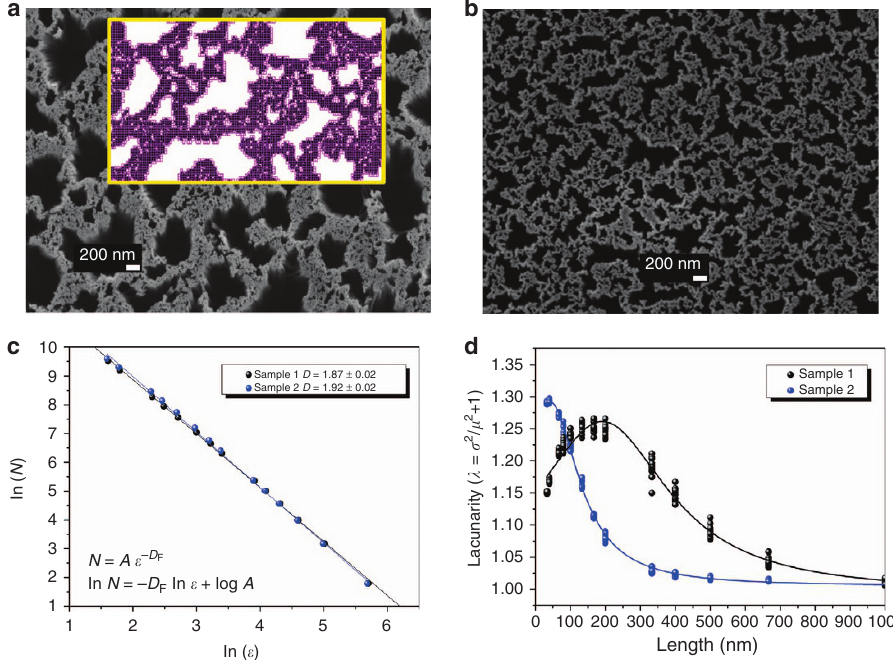
Figure 2 Characterization of 2D random fractal structures of Si NWs. Si NW samples 1 ( a ) and 2 ( b ) plan view SEM images used for Fraclac analysis. Details of the analysis with sectioning in square boxes in the reduced sample portion are shown in the inset of panel a. The fractal dimension and lacunarity plots obtained as analysis results are shown in ( c and d ), respectively. Note that the pixel size is 6.7 nm. Hence, length (nm) = ε (pixel)×6.67 (nm per